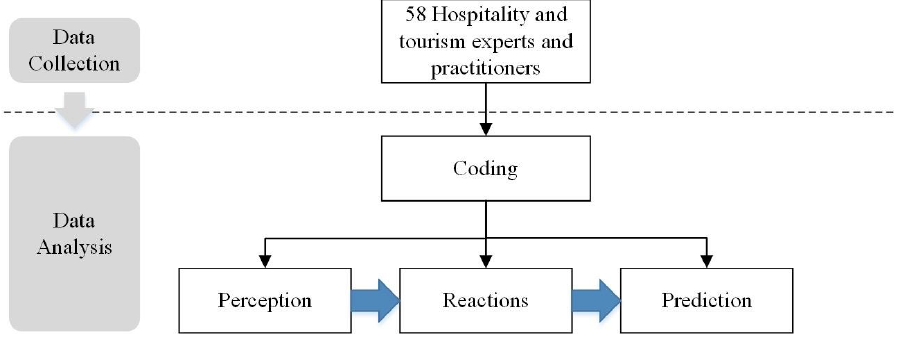
Figure 1. Research flow chart.